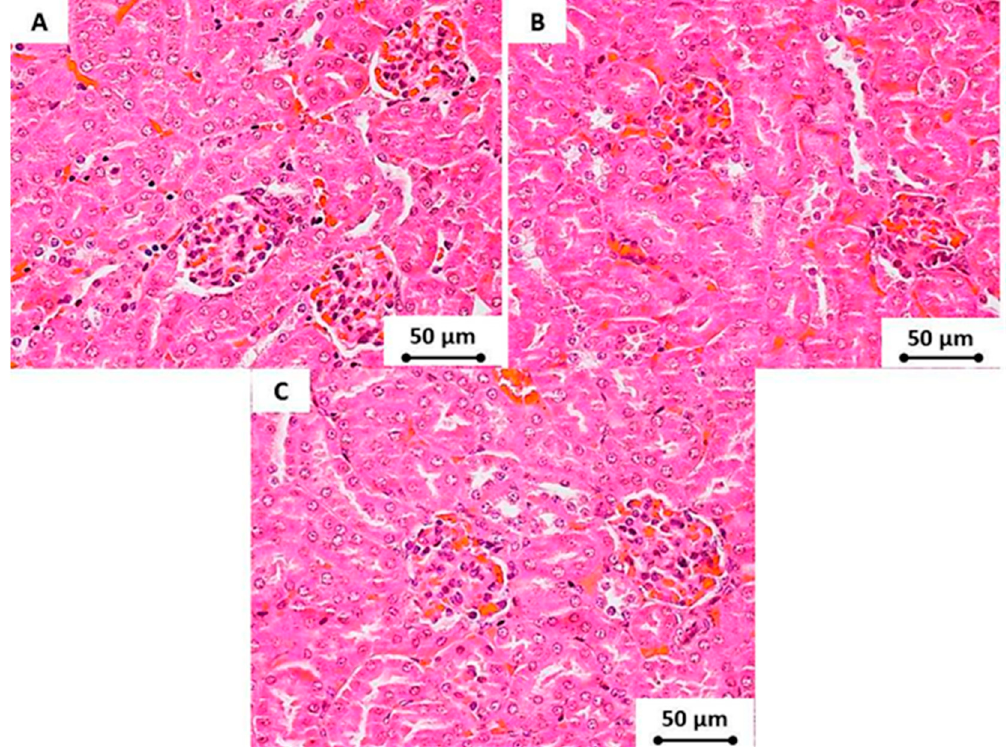
Figure 9. The renal tissue (at 400× magnification) of the tested subjects that were administered ( A ) tap water, ( B ) low doses of CNDs (10 mg/kg), and ( C ) high doses of CNDs (50 mg/kg) after 4 weeks. There were no pathological changes in any of the tested groups.